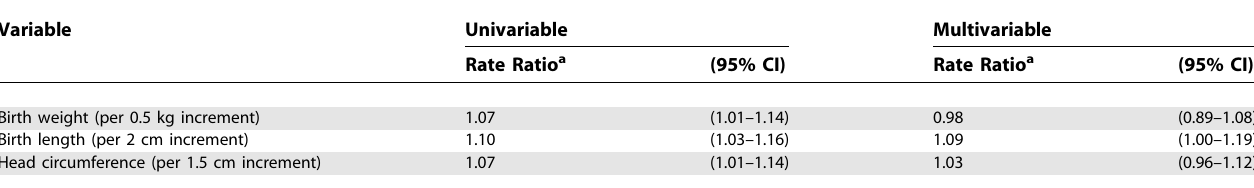
Table 2. Separate (Univariable) and Mutually Adjusted (Multivariable) Breast Cancer Incidence Rate Ratios for Continuous Weight, Length, and Head Circumference at Birth in Singletons